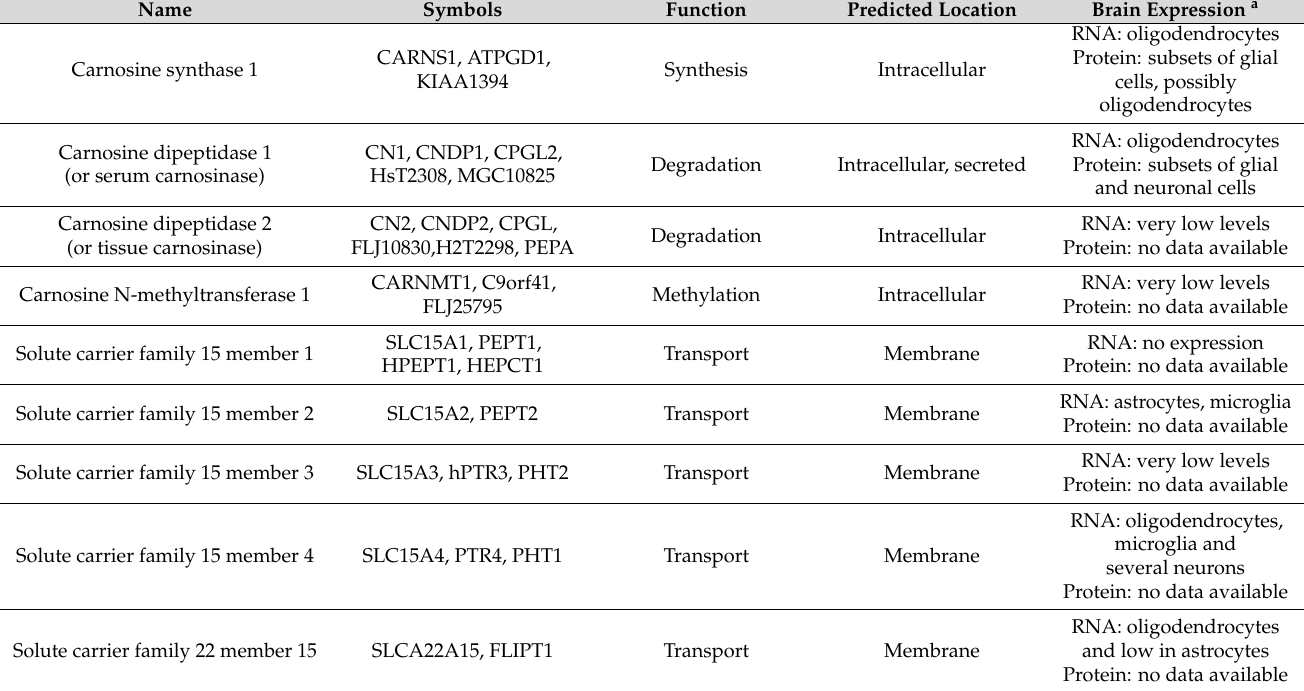
Table 1. Human proteins involved in carnosine